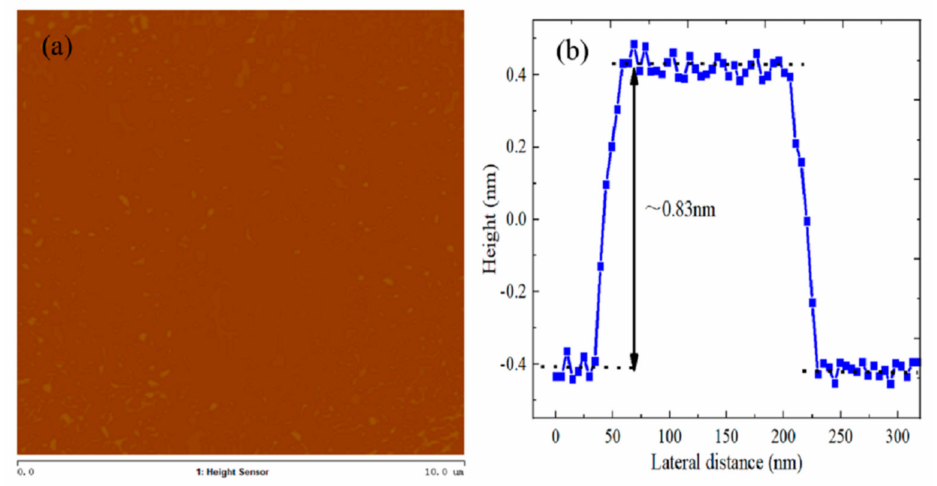
Figure 4. ( a ) AFM image and ( b ) height profile of WS 2 material.